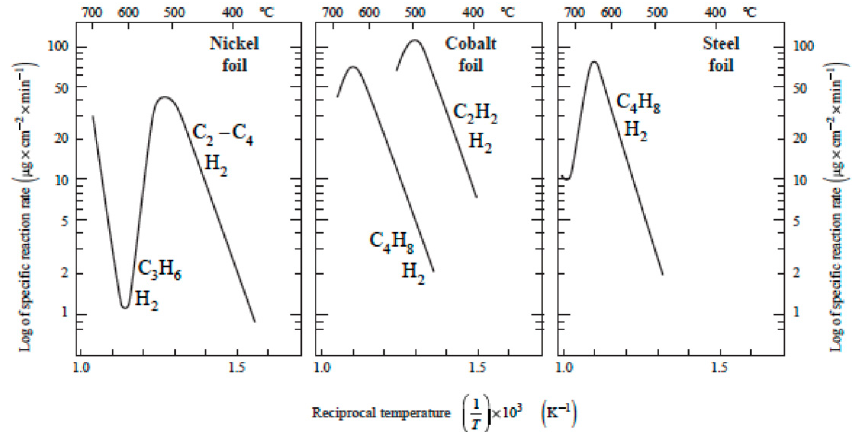
Figure 2. Arrhenius plots of the rates of C formation on Ni, Co, and steel foils [3,5,7]. Rates of C growth (µg/cm 2 ·min) vs. reciprocal temperature (1/ T ) × 10 − 3 (K − 1 ).